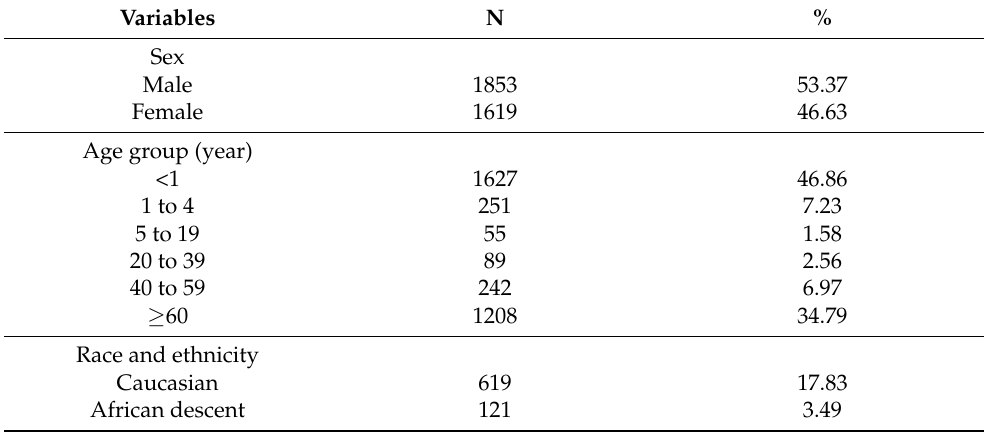
Table 1. Epidemiological characteristics of deaths from diarrhea and infectious gastroenteritis in the state of Alagoas, Northeast Brazil between 2000 and